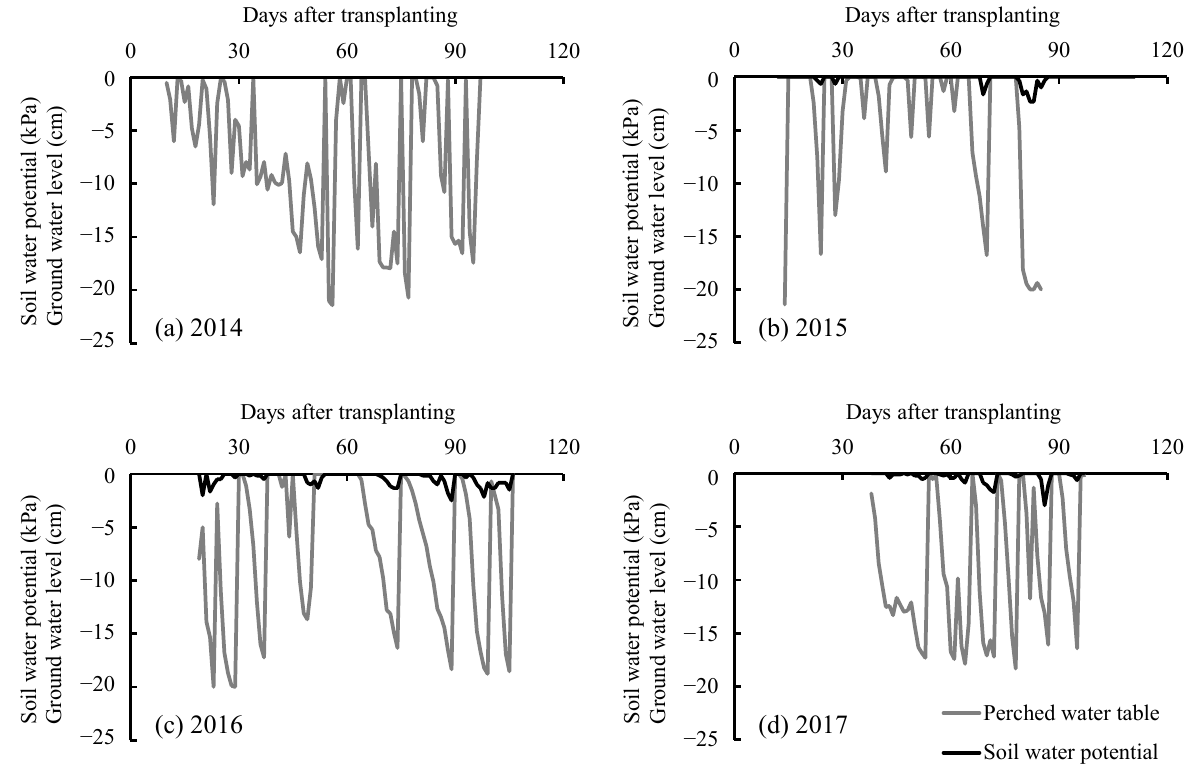
Figure 2. Soil water potential and perched water table in plots with alternate wetting and drying (AWD) during the 2014 ( a ), 2015 ( b ), 2016 ( c ), and 2017 ( d ) seasons. Gray lines represent the perched water table, while black lines indicate the soil water potential. X-axis shows the days after transplanting.